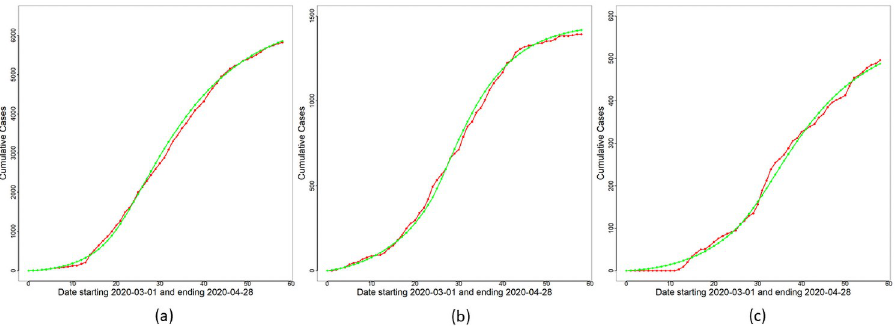
Fig 6. Modified SEIR model: Cumulative cases. Reported cumulative cases (red line), and overlay plots of R (green line) based on ^ Y for (a) Malaysia, (b) Selangor and (c) Sarawak. MAP